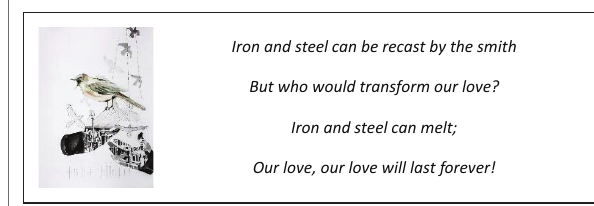
FIGURE 9: Von Ewiger Liebe.